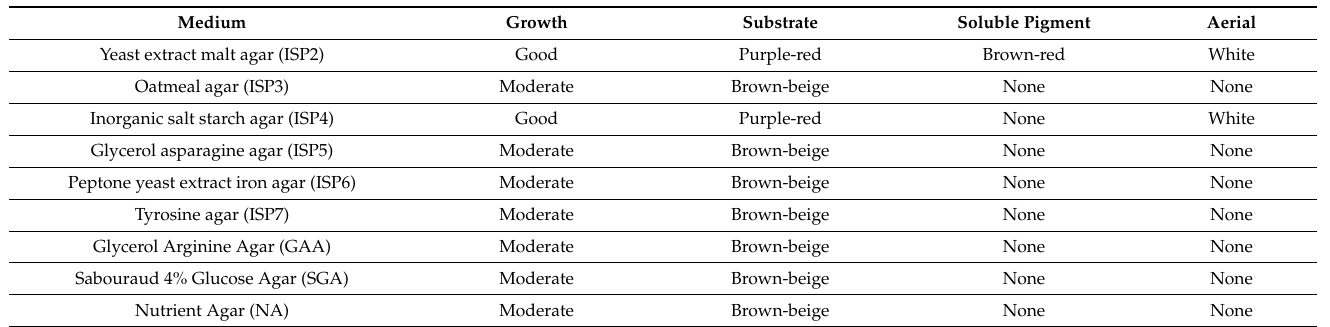
Table 1. Cultural characteristics of Streptomyces sp. ADR1 strain.